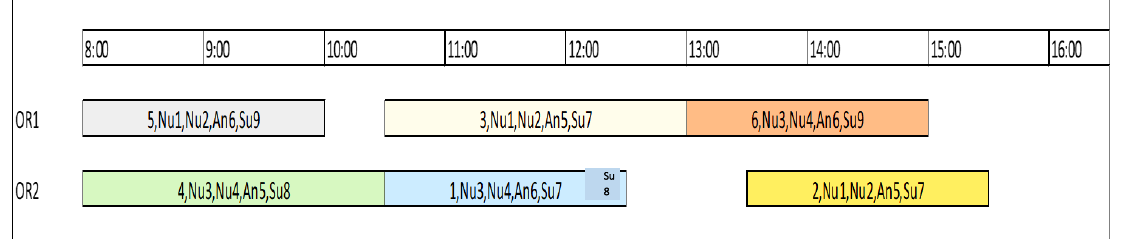
Figure 1. Gantt chart of the optimal solution using GAMS.